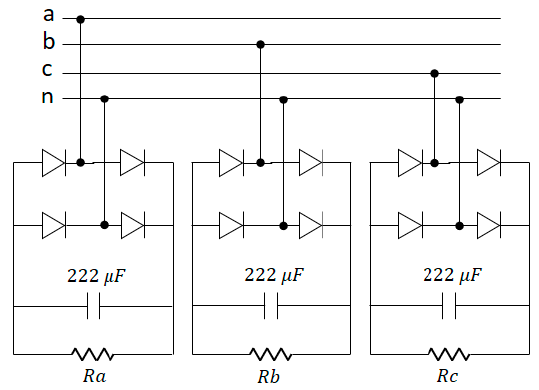
Figure 5. Single-phase full-wave rectifier (loads 2 and 3).